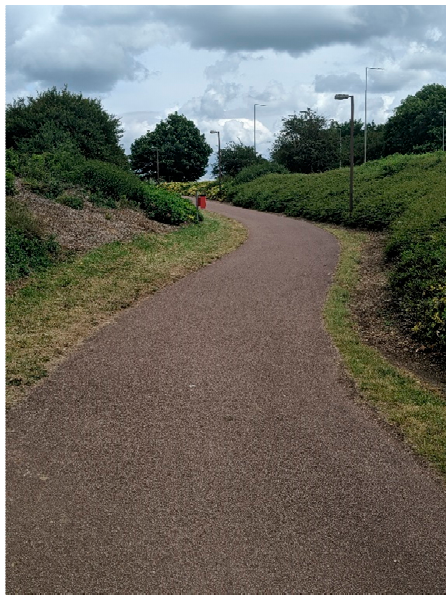
Figure 4. A Redway in the Kent’s Hill District of Milton Keynes. Permission granted by Marston.